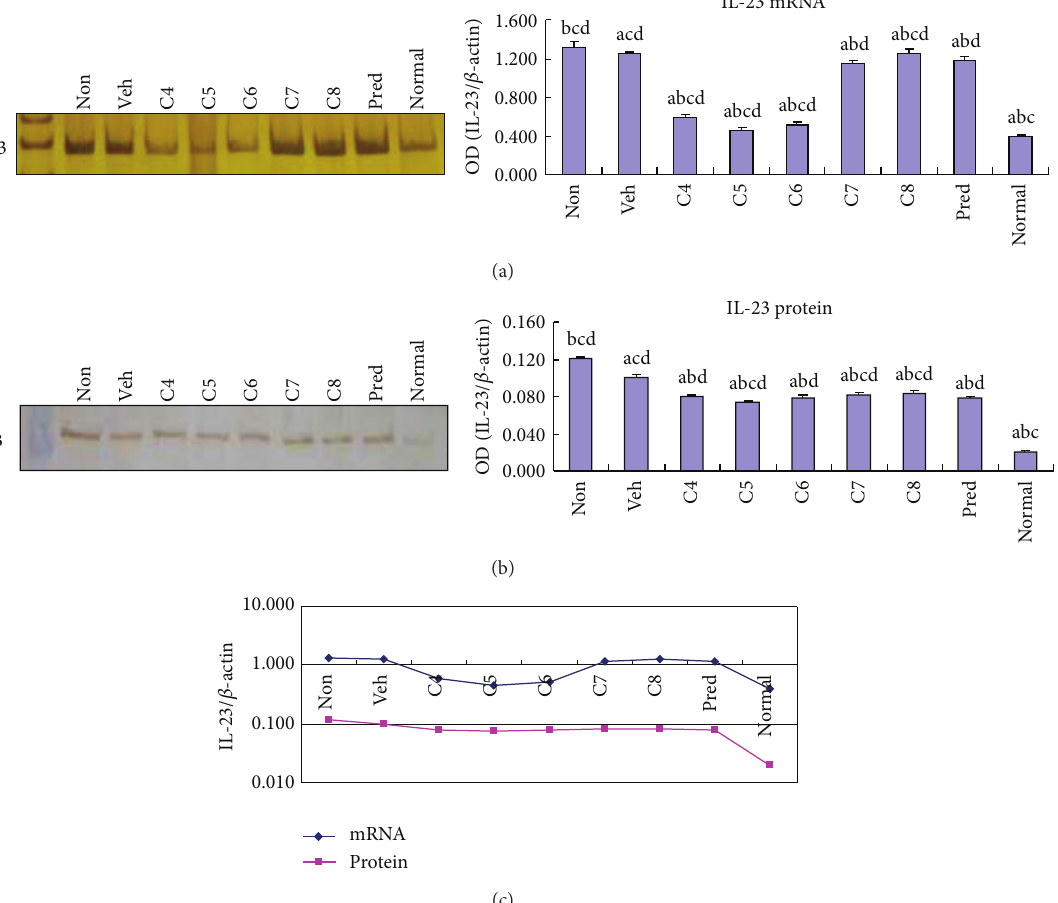
Figure 3: Lactobacillus acidophilus administration decreased IL-23 expression in colitis. The mRNA (a) and protein (b) levels of IL-23 expression were examined by RT-PCR and Western blotting, respectively, in the colonic tissues of normal control mice group (normal) and DSS-induced mice groups, including L. acidophilus -treated C4–C8 groups, prednisone acetate treated positive control (Pred), and nontreated (Non) and vehicle (Veh) treated control groups. Representative electrophoresis images are shown on the left, and bar graphs presenting mean ± SD ( 𝑛 = 8 ) values are shown on the right. A plotted trendline chart shows IL-23 expression in each group at both mRNA and protein levels (c). a 𝑃 < 0.05 versus Non, b 𝑃 < 0.05 versus Veh, c 𝑃 < 0.05 versus Pred, and d 𝑃 < 0.05 versus